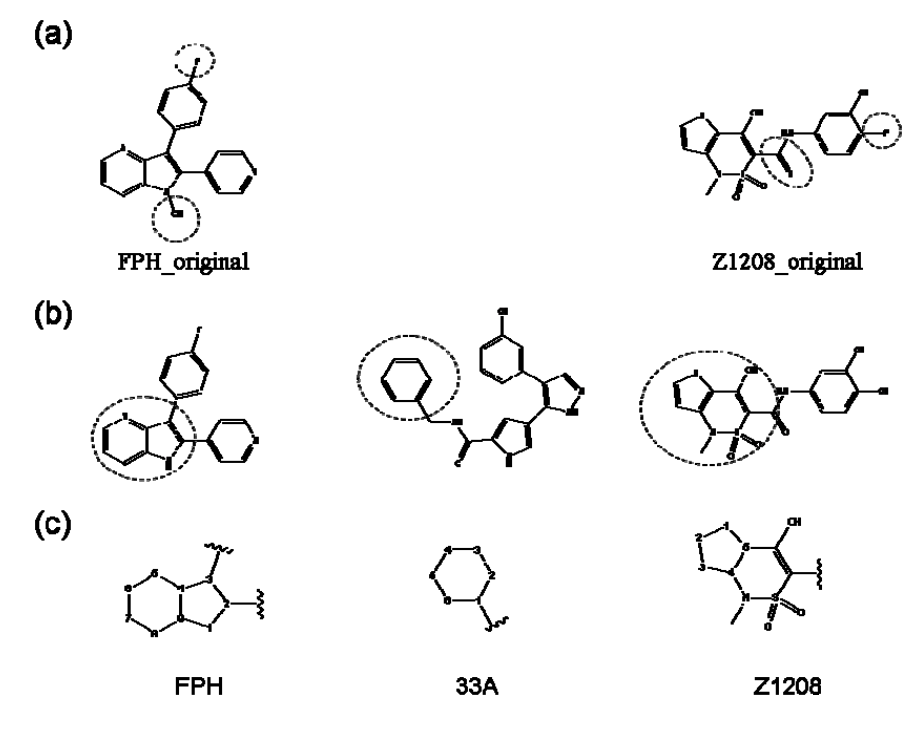
Figure 1. Chemical structures of th e native compounds and modifications made to create the input files for our calc ulations (see text for details). T he portion surrou nded by the dotted circle was replaced as indicated in the text, and pos ition numbers are displayed for illustrative